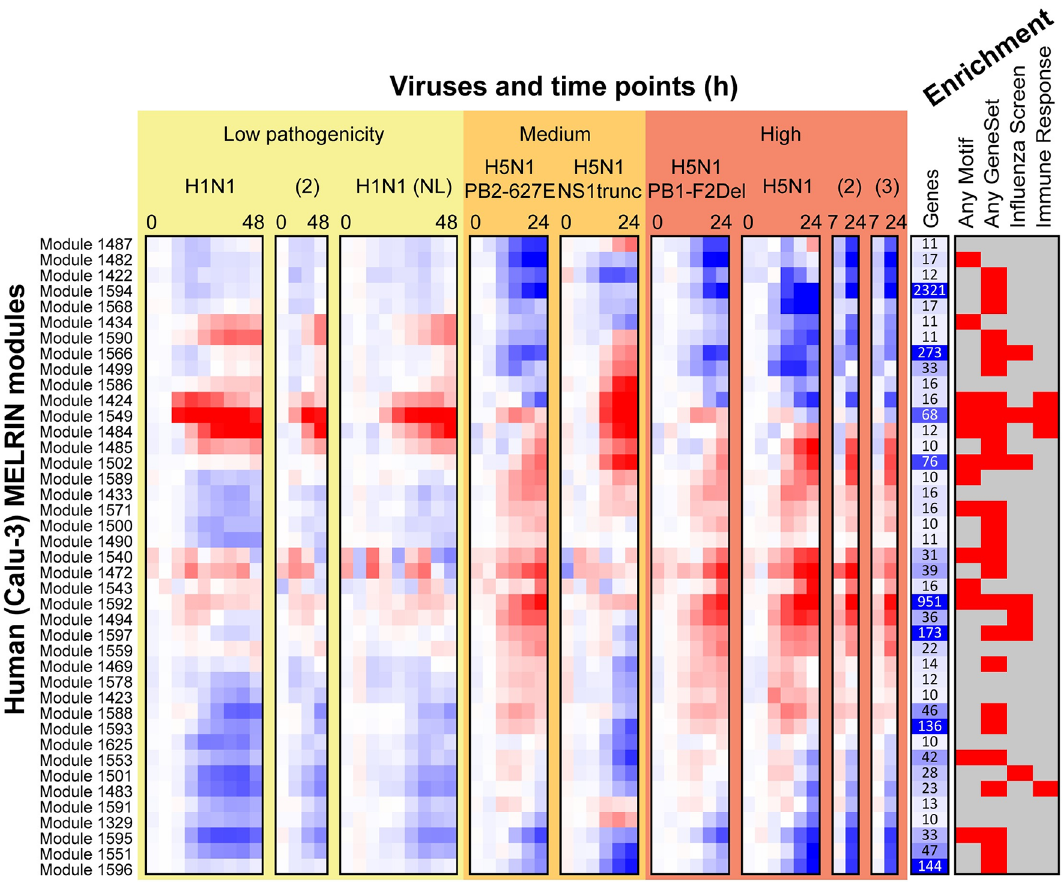
Fig 2. Overview of human influenza response module expression patterns. Shown are 41 human Calu-3 modules with at least 10 genes. The red-blue heat map shows mean expression of all genes in each module. The more red an entry the higher the expression in infected versus mock, while the more blue the entry, the higher the expression in mock compared to the infected sample. Under “ Viruses and time points (h) ” , each virus treatment's time series is shown separately, and viruses are ordered from low to high pathogenicity. Low-pathogenicity samples labeled H1N1 used A/CA/ 04/09 H1N1 unless labeled '(NL)' for A/Netherlands/602/09. Samples labeled H5N1 used A/VN/1203/04 H5N1 and laboratory mutants thereof. The “ Genes ” column shows the size of each module; larger values are shown in darker blue. Under “ Enrichment ” , a red box indicates module enrichment with any MSigDB motif, any MSigDB gene set, any Gene ontology process, any influenza screen set, or any immune response gene set ( Methods